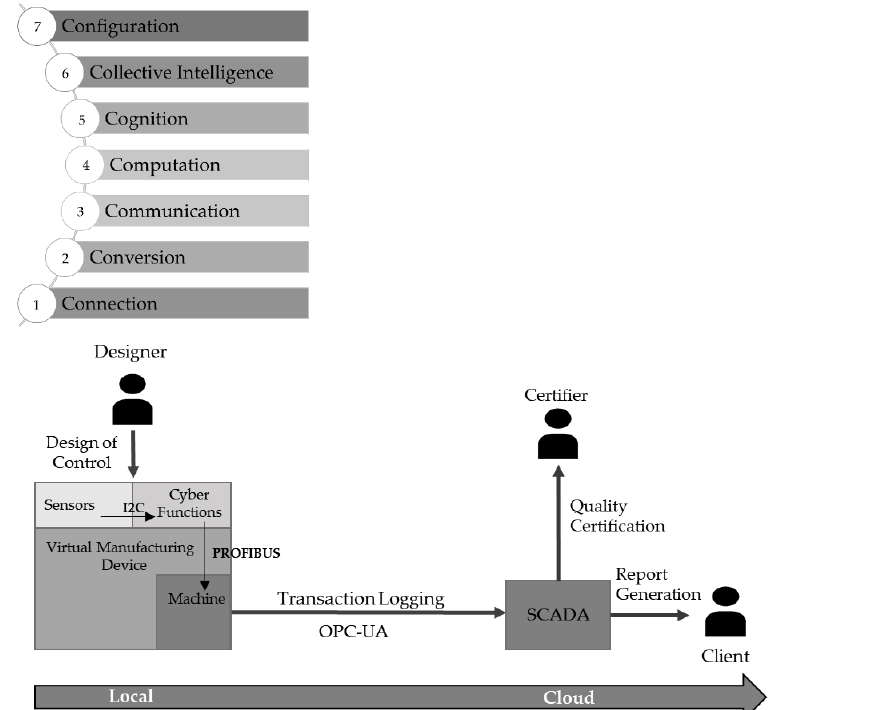
Figure 7. 7C Protocol, adopted from [112] & Metamodelling of process control scenario including certification framework and transactions .